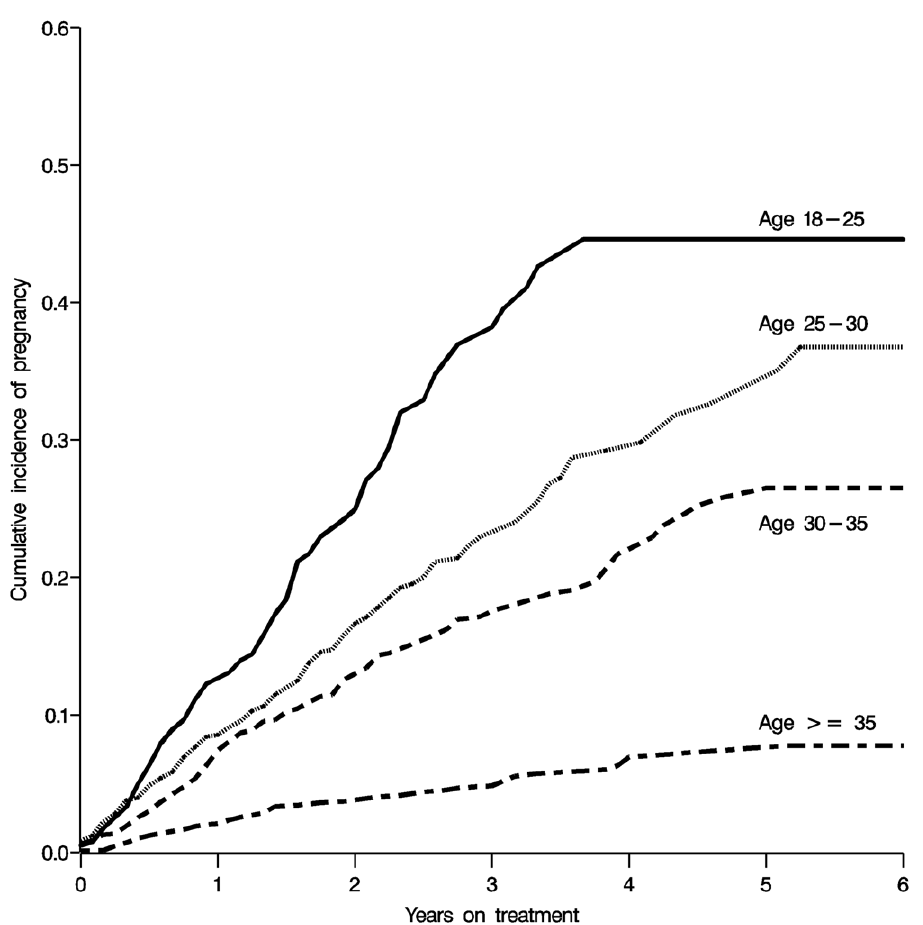
Figure 1. Crude cumulative incidence of pregnancy since date of HAART initiation, stratified by baseline age among 5,494 HIV- positive women initiating HAART in Johannesburg, South Africa from 1 April 2004 to 30 September 2009.